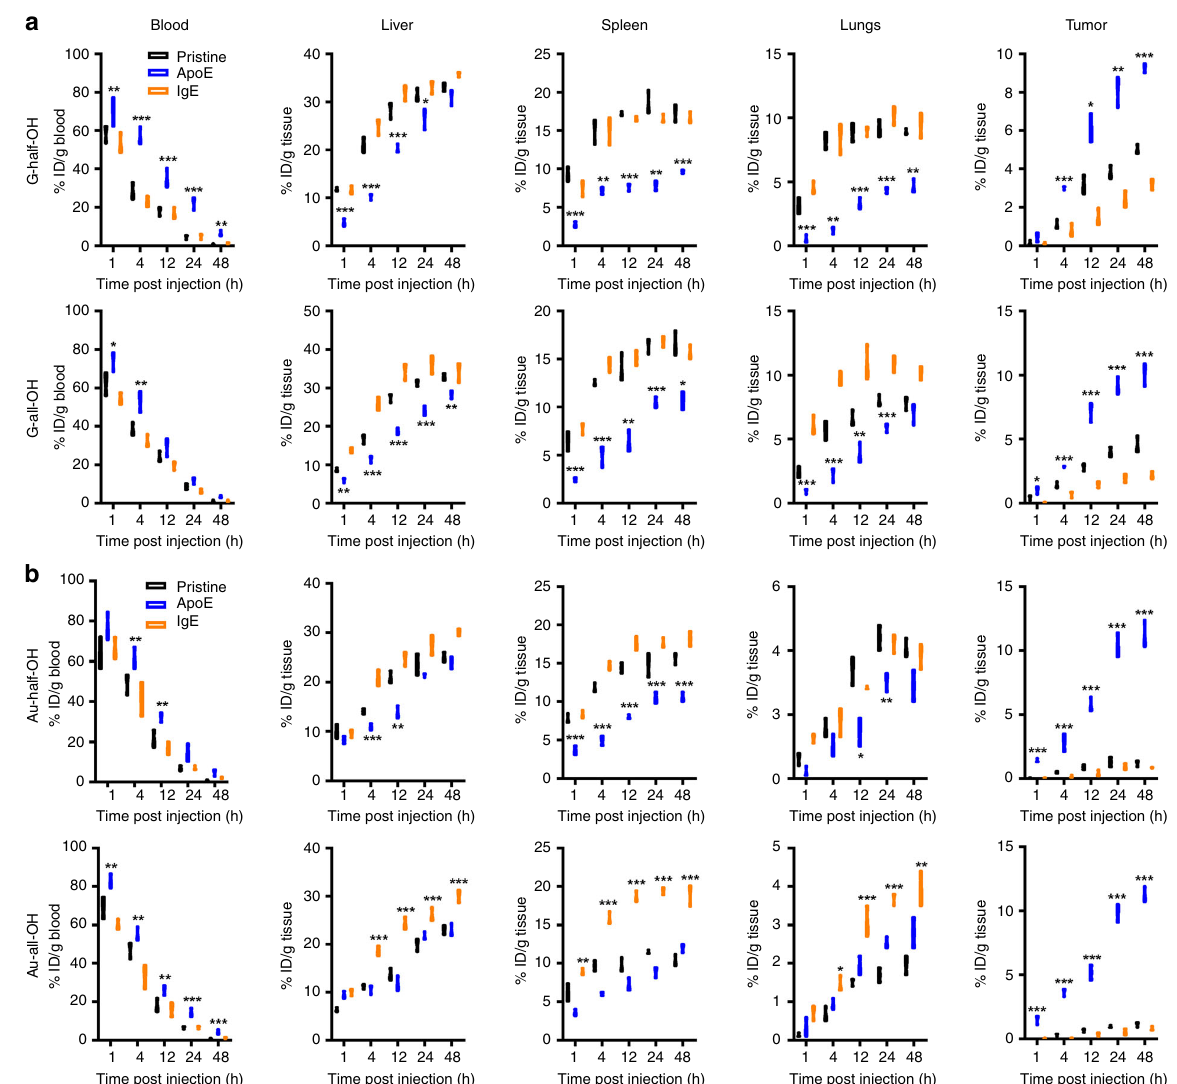
Fig. 7 Biodistribution pro fi les. a , b Biodistribution of G-half/all-OH and Au-half/all-OH in four tissues including liver, spleen, lungs, and kidneys in addition to blood, respectively. Data are presented as mean ± s.e.m. ( n = 3 at each time point) as a function of time. p Values were calculated using multiple t tests (*** p < 0.001, ** p < 0.01, * p <